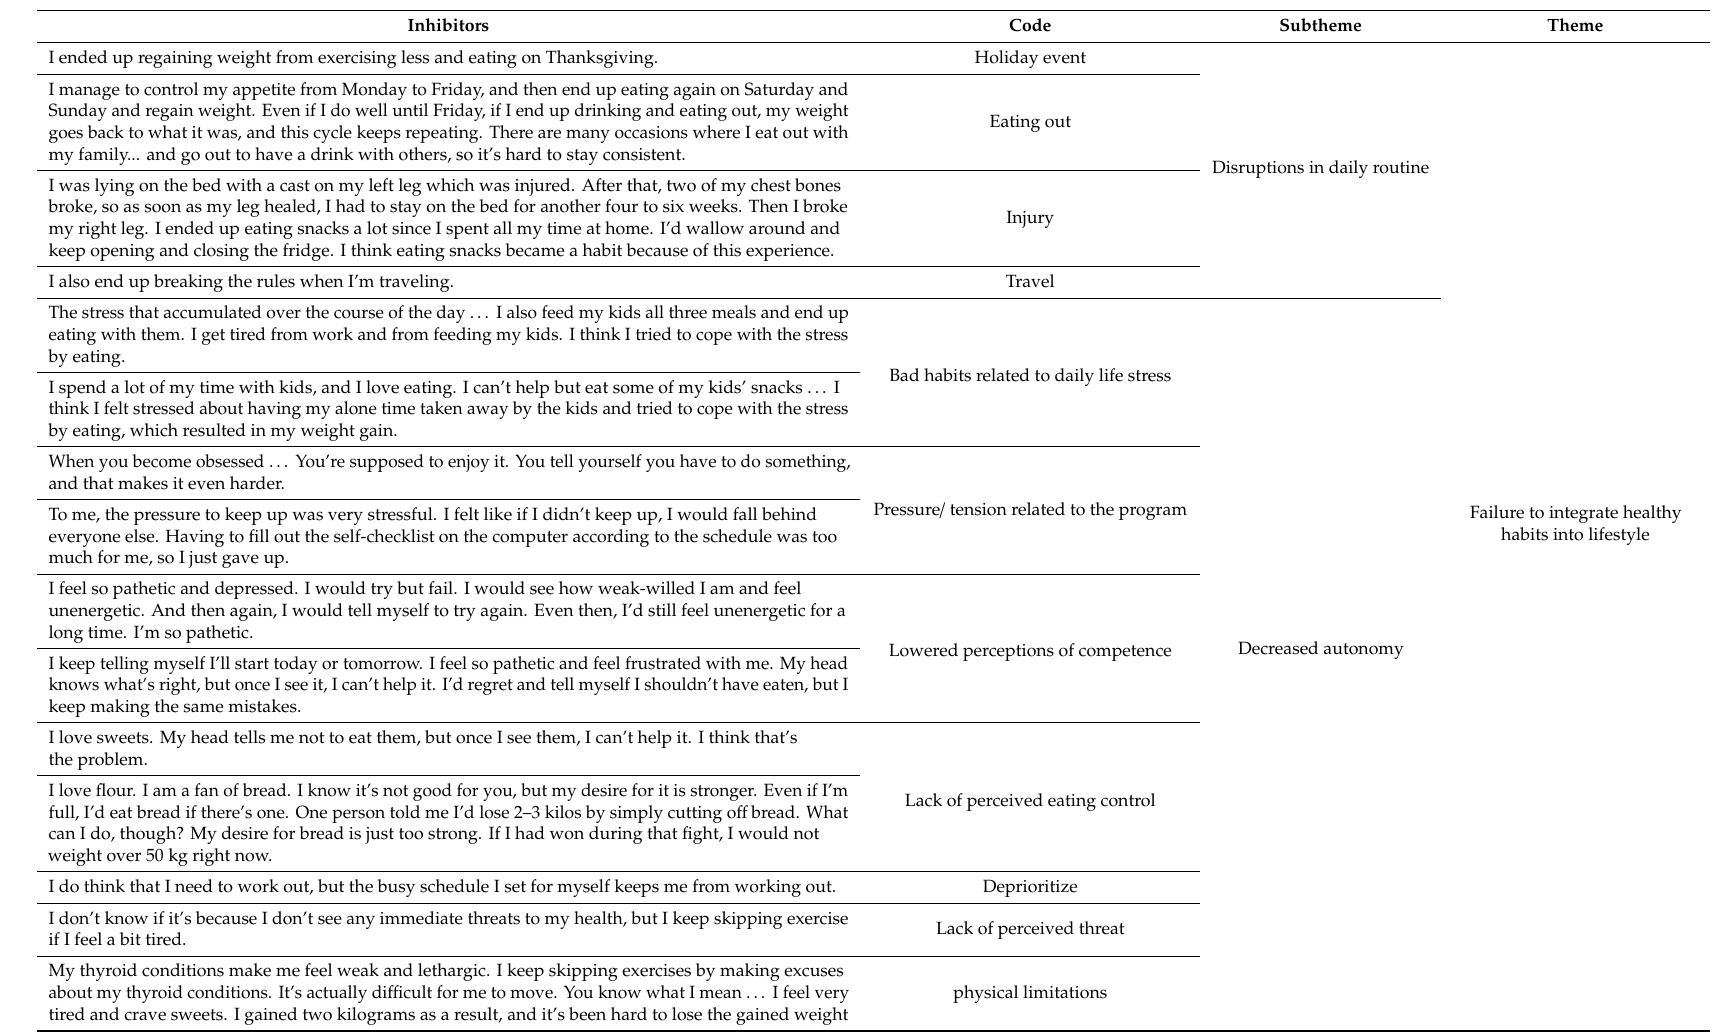
Table 3. Inhibitors of healthy lifestyle modification and